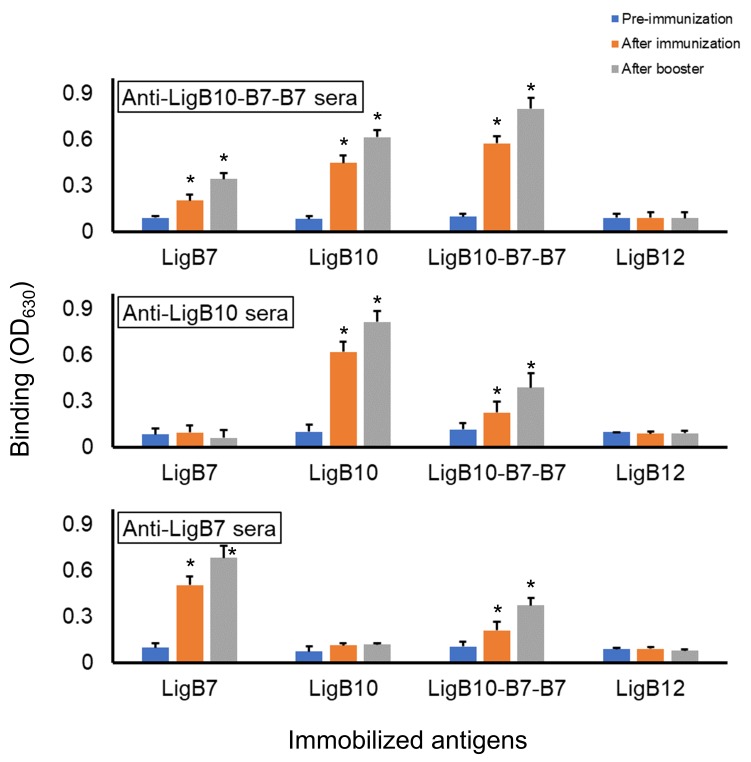
Detection of humoral response.The serological fluid of hamsters immunized with recombinant LigB Ig-like domain vaccines showed strong antibody generation against the corresponding domain antigens in an ELISA assay (orange, after immunization; gray, after booster). Anti-LigB10 and Anti-LigB7 sera exhibited immunoreactivity against LigB10-B7-B7 but not LigB12 (negative control) while Anti-LigB10-B7-B7 sera exhibited immunoreactivity against LigB10 and LigB7 but not LigB12 (negative control). All experiments were conducted in three trials, the mean ± S.D. of which were shown in bar charts. Positive sera immunoreactivities were identified by comparing with LigB12 and statistically significant (t-test; p<0.05) differences were marked by an asterisk.